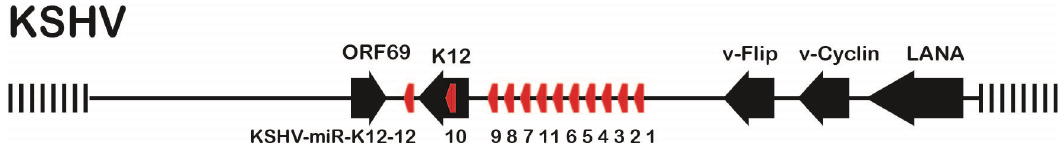
Figure 1. KSHV Latency-Associated Region (KLAR) showing open reading frames (black arrows) and miRNAs (red arrows). The region between LANA and K12 on the minus strand is located between nts position 129,256 (LANA ATG) and 117,738 (K12 UGA) on the KSHV Bac16 genome (Accession number GQ994935).